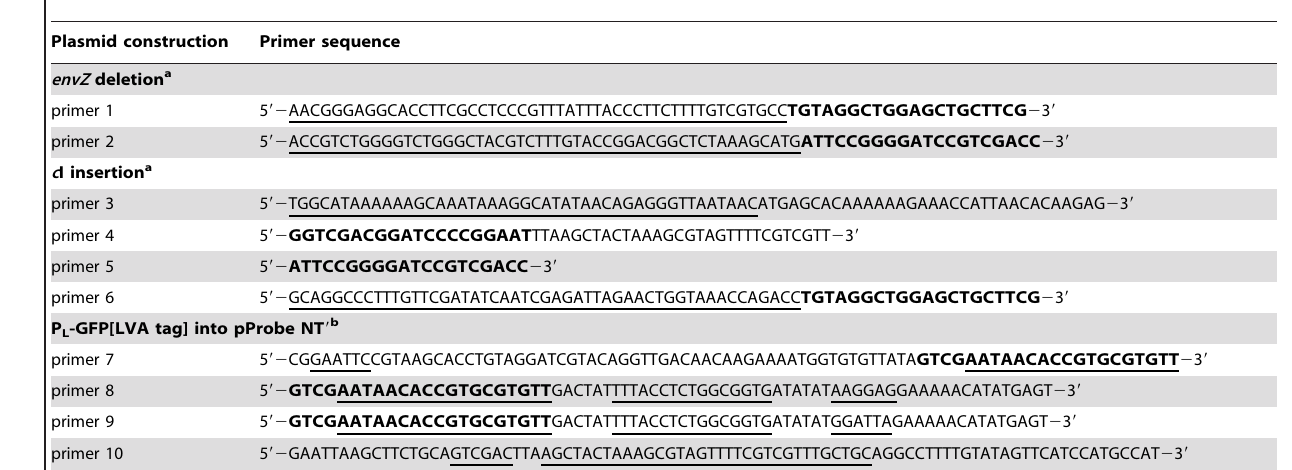
Table 2. Primers used in this